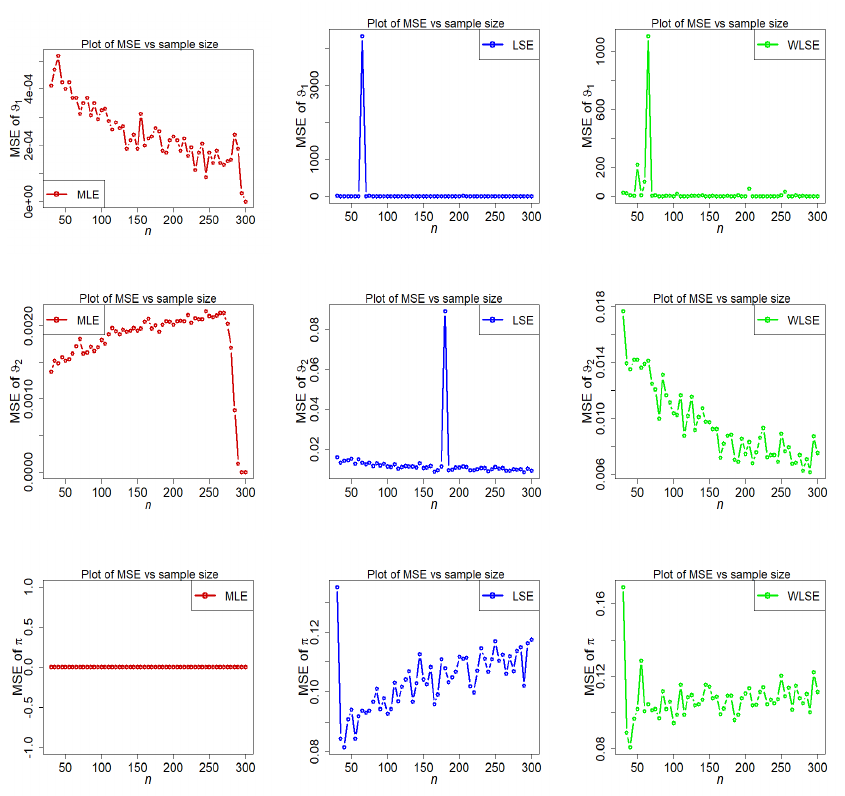
Figure 9. Fluctuations of bias of estimators under different methods for parametric set II.